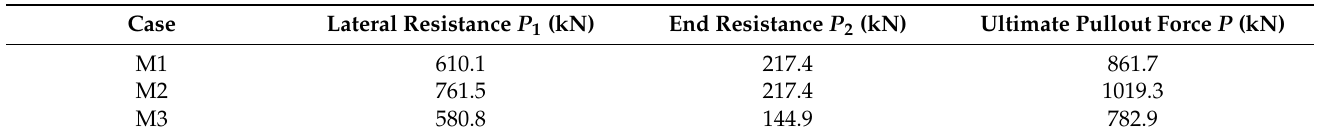
Table 2. Theoretical